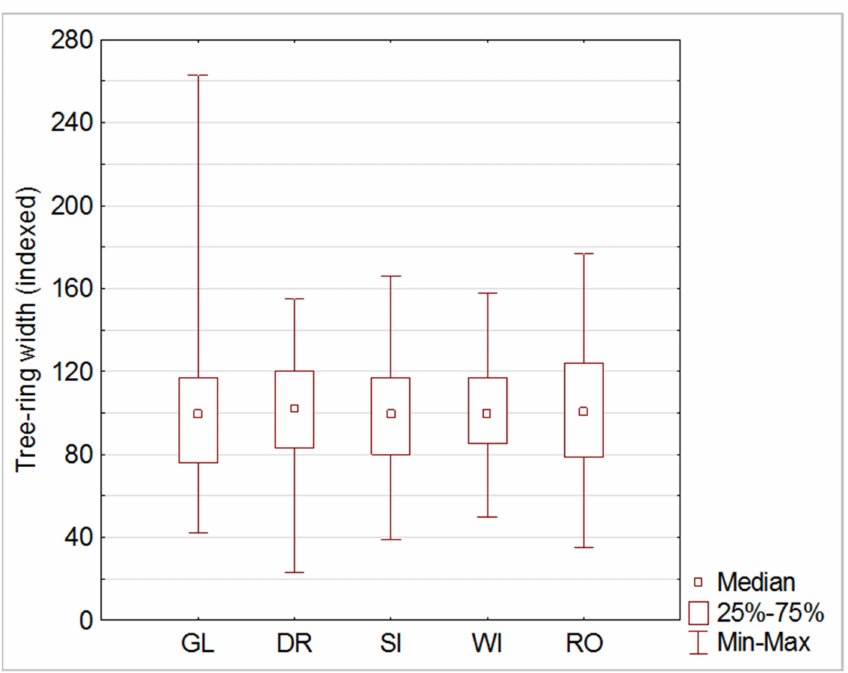
Figure 3. Box and whisker plot presenting descriptive measures for tree-ring width (indexed). Boxes show the position of the lower and upper quartile, and whiskers represent the minimum and maximum values.